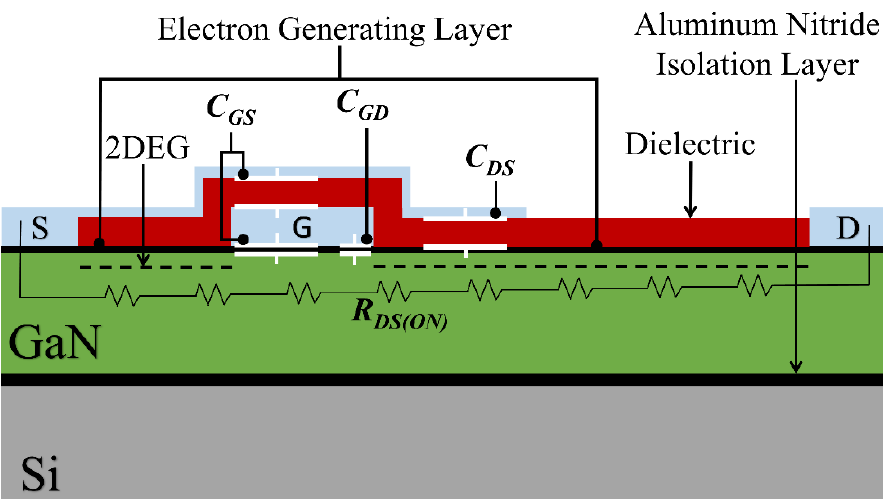
Figure 1. Internal cross-sectional structure of a gallium nitride based high-electron-mobility-transistor (GaN-HEMT).